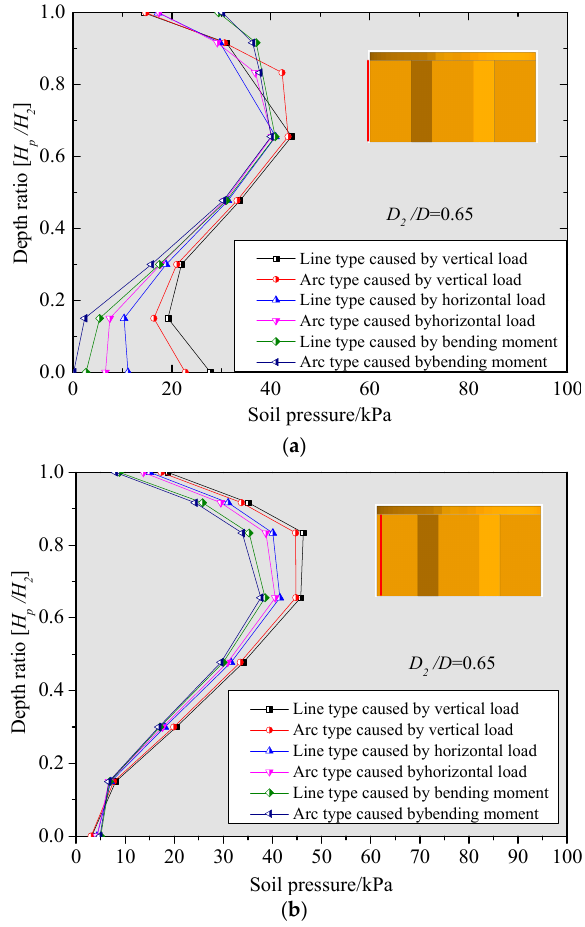
Figure 12. Soil pressures on the back bucket: ( a ) Outside skirt; ( b ) Inside skirt.